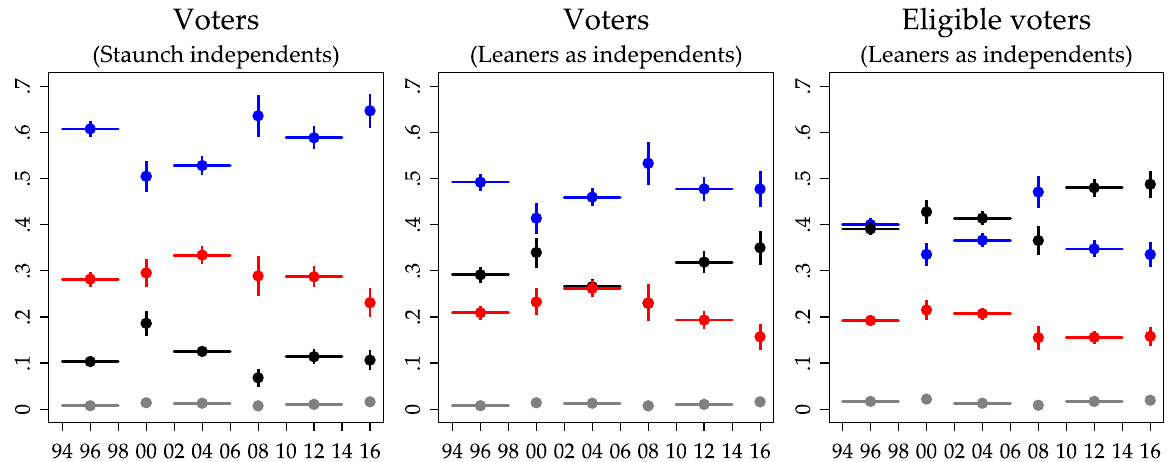
Figure 3: Class VIIa trends in identification with the Democratic Party (blue), Republican Party (red), another party (gray), and independent